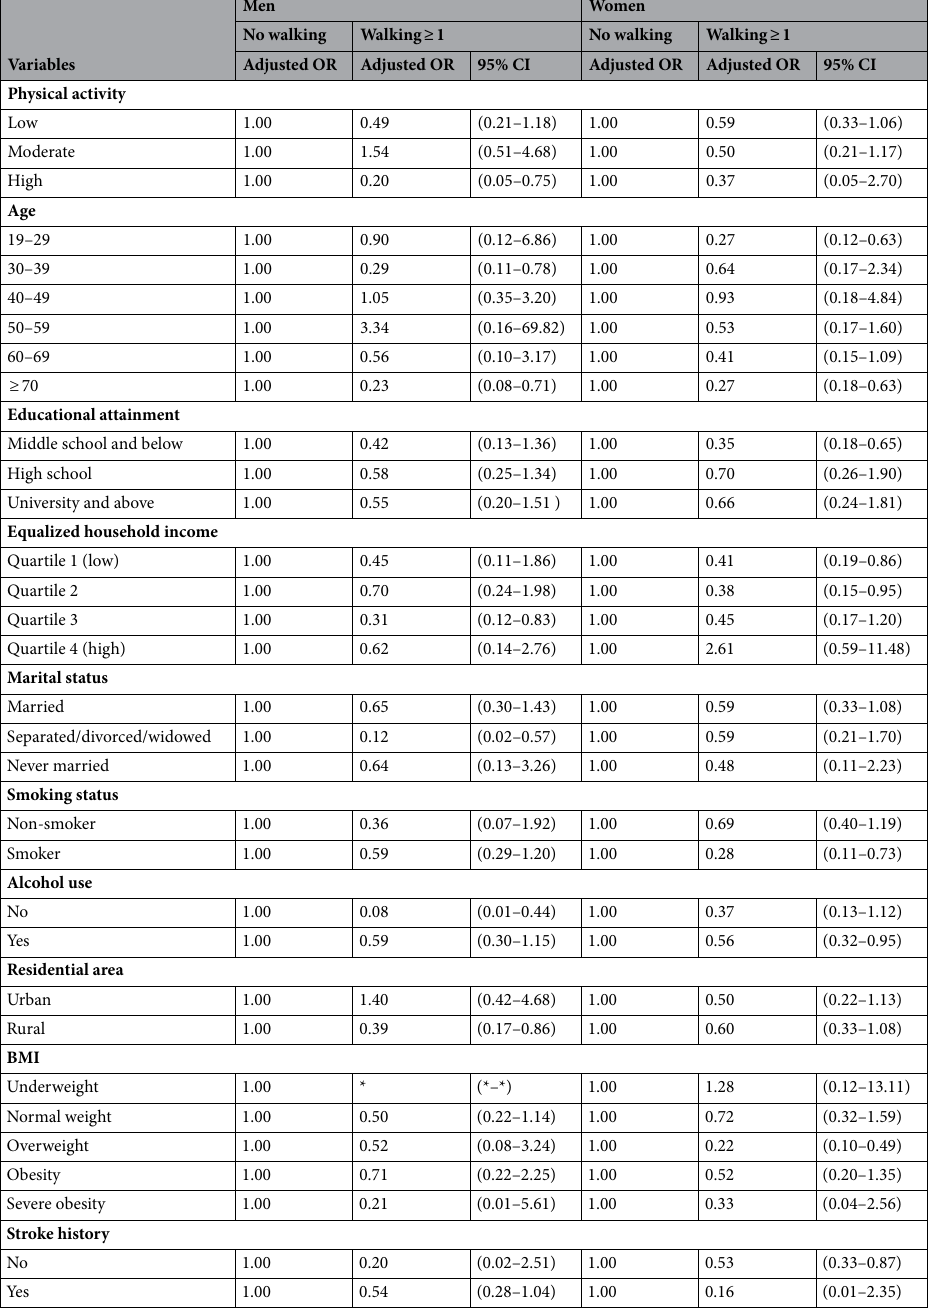
Table 4. Subgroup analysis of the association between walking and depression stratified by sociodemographic variables. PHQ-9 patient health questionnaire-9, BMI body mass index, Underweight BMI < 18.5,